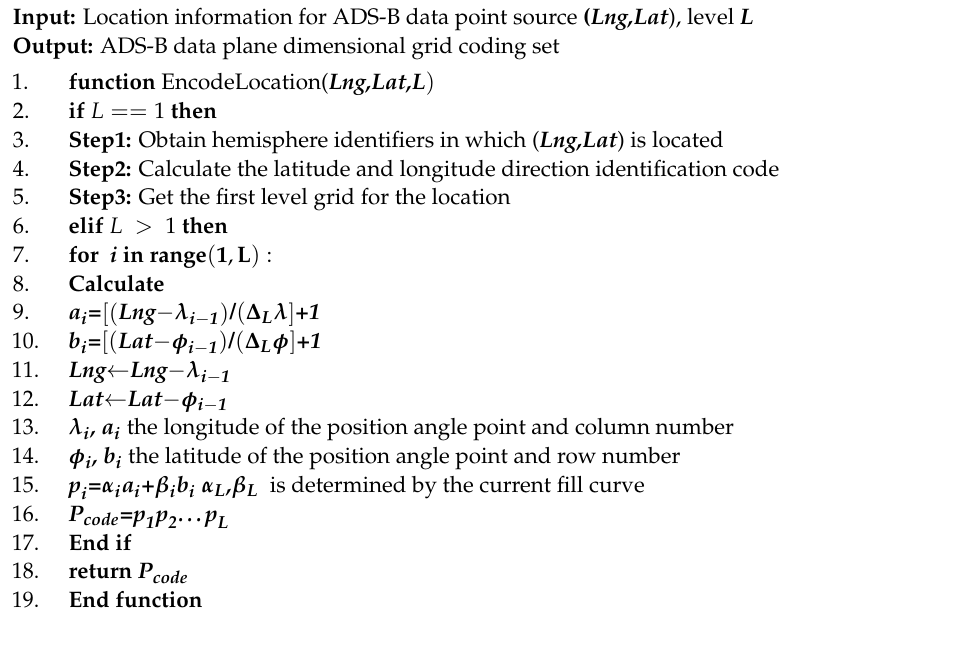
Algorithm 1 Grid set generation algorithm for latitude and